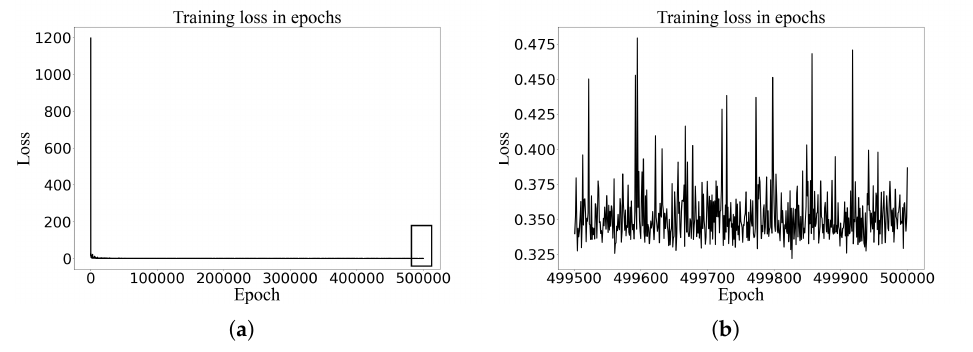
Figure 5. Convergence curve. ( a ) Iterative steps: 1–500 k; ( b ) Iterative steps: 499,500–500